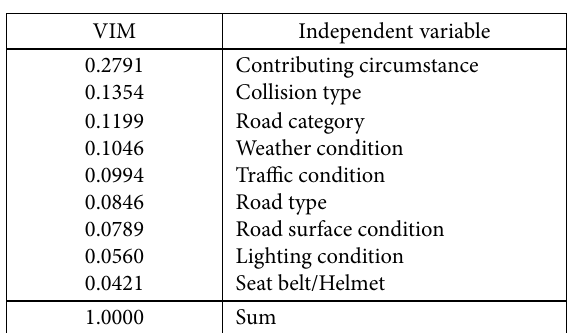
Table 3. Importance of variables in the case of